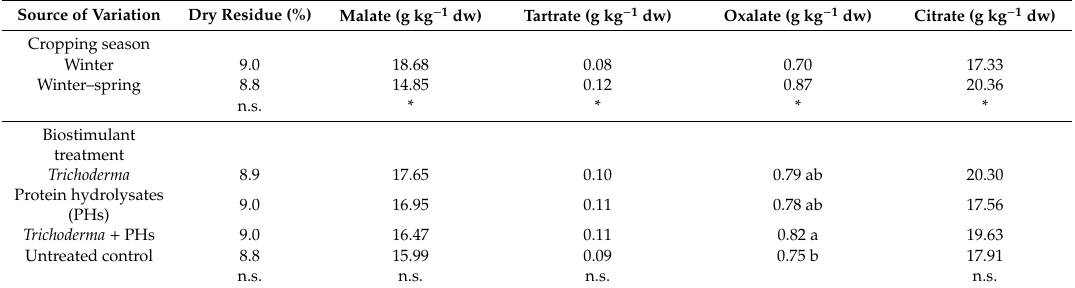
Table 3. E ff ect of cropping season and biostimulant treatment on perennial wall rocket leaf dry residue and organic acid